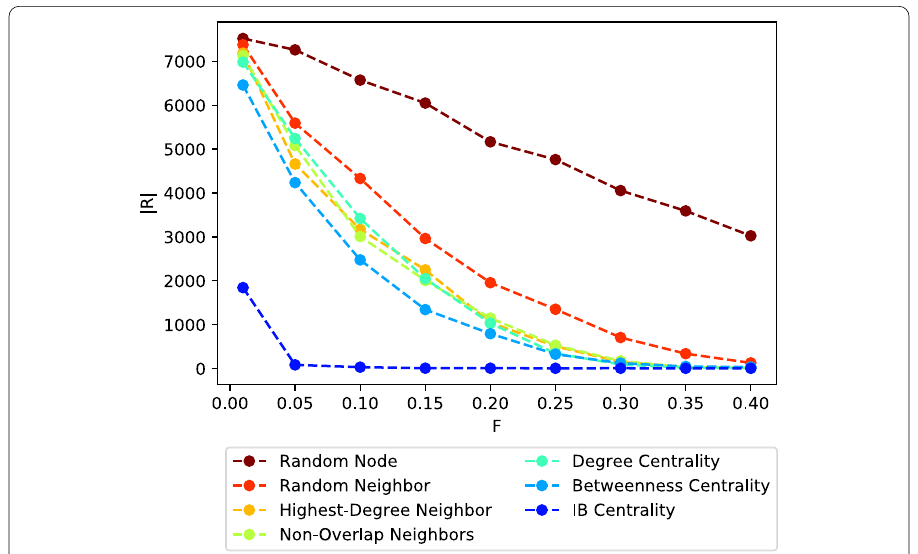
Fig. 5 Average number of infected nodes after convergence | R |, as a function of the vaccination budget F . IB Centrality (blue plot) remains the best performing strategy for all considered values of